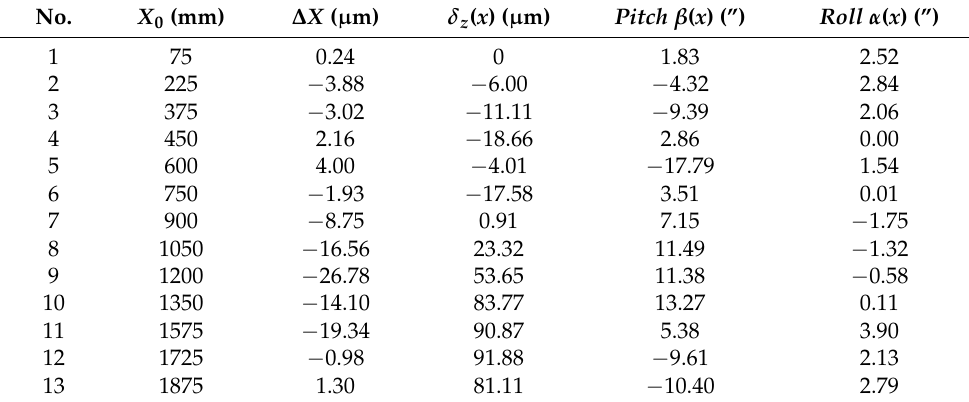
Table 2. Stage position and orientation.